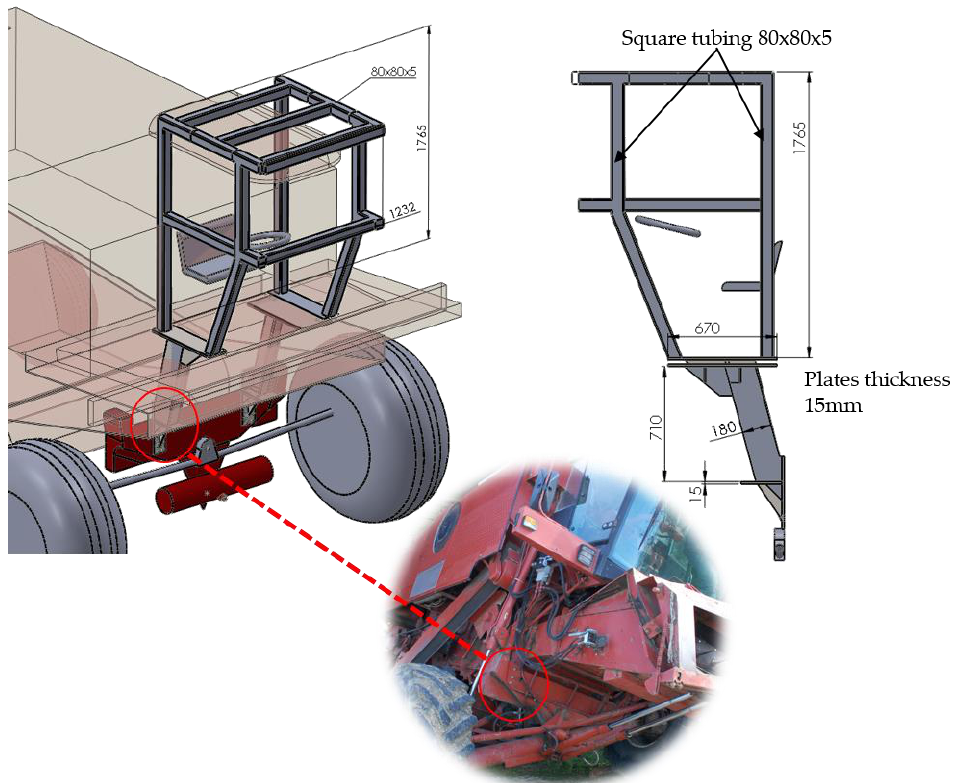
Figure 11. Combine harvester TOPS structure: fastening zones and dimensional features in (mm).